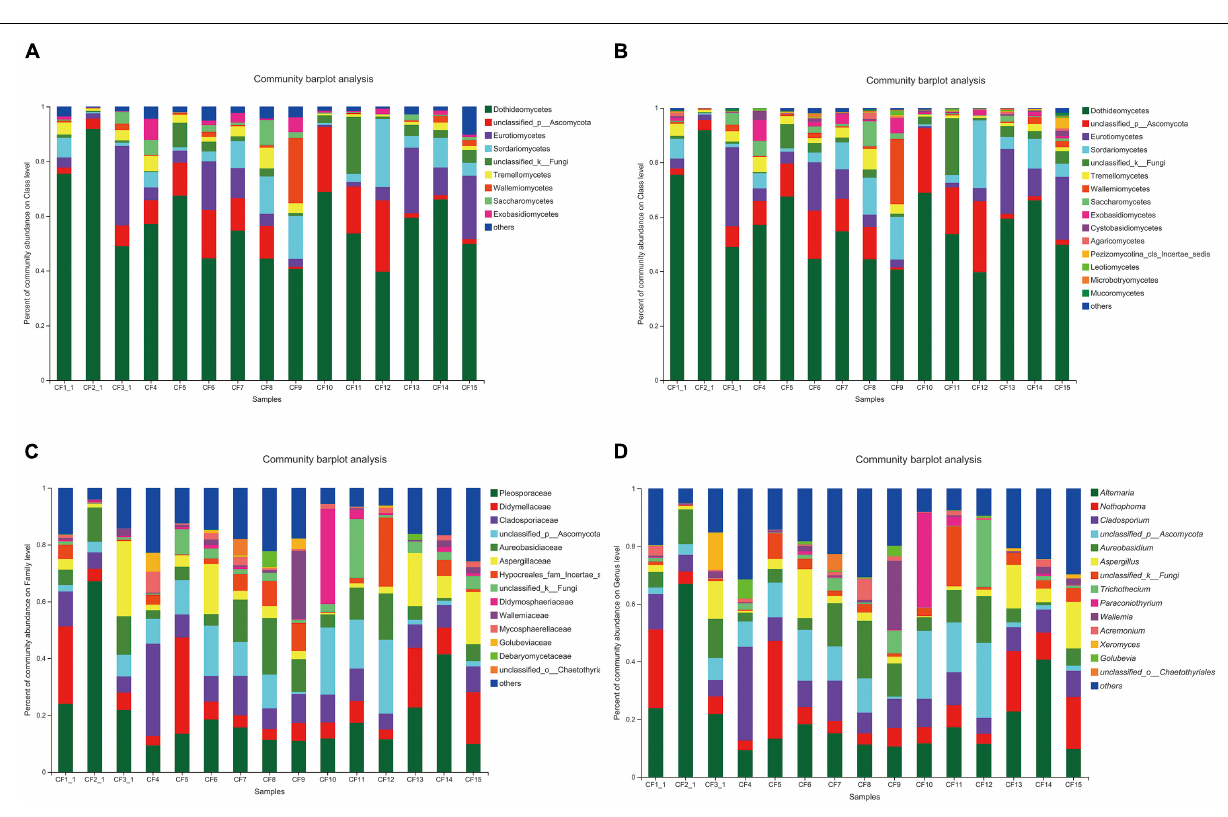
( Figure 4C ). At the genus level, the relative abundance of Alternaria (0–66.92%) was highest among the 207 identifiable genera ( Figure 4D